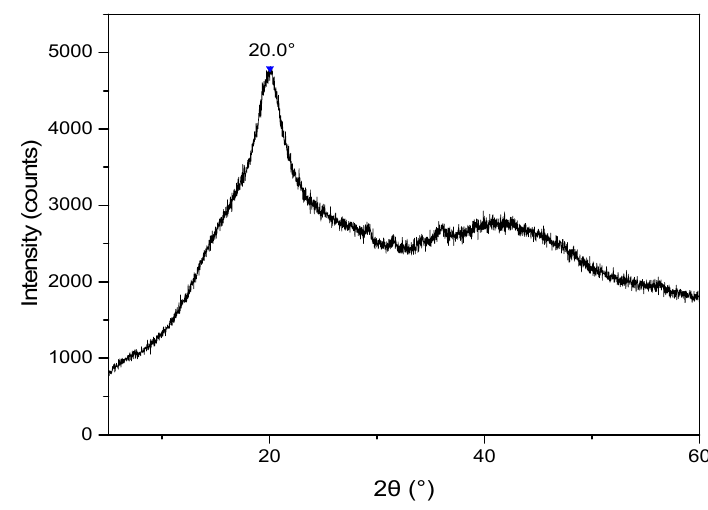
Figure 1. XRD pattern of the chitosan beads (CB).